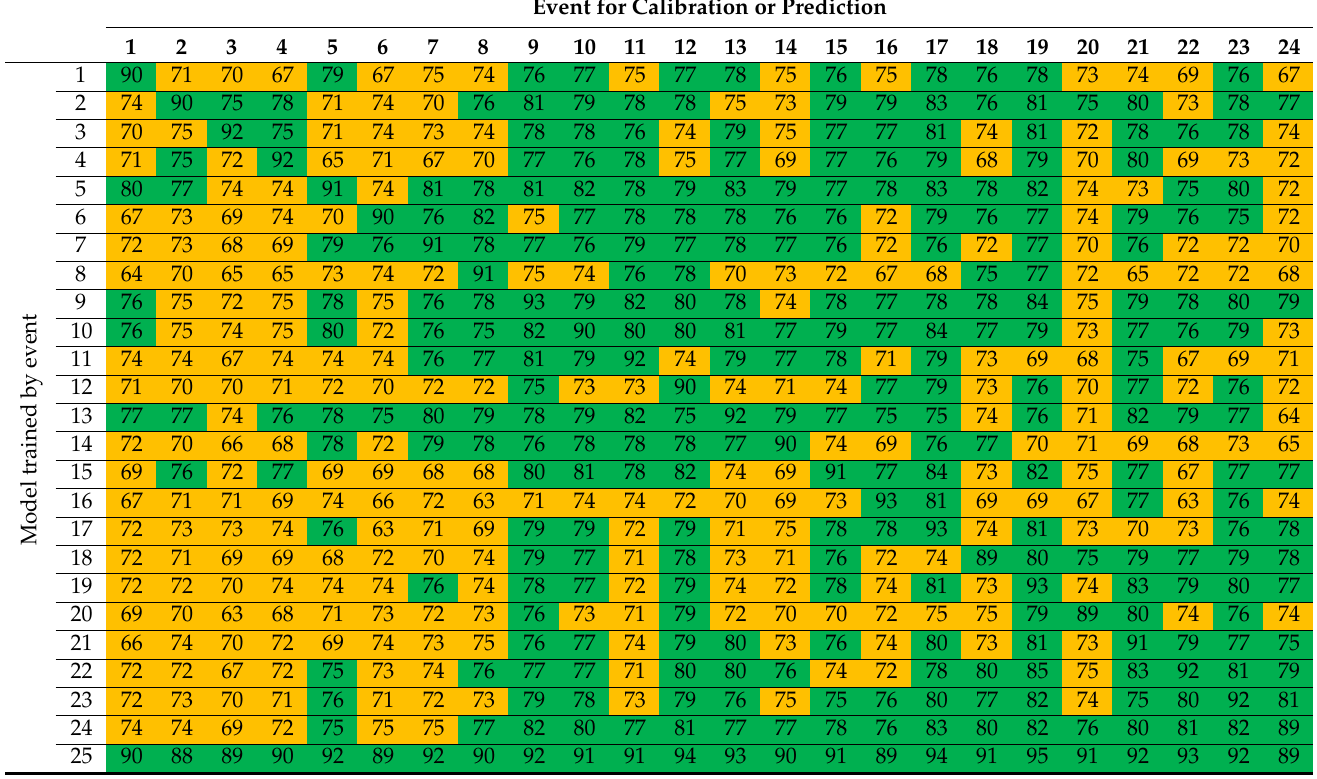
susceptibility models. In Figure 13, the average predictive accuracy of event-based PME models ( i = 1–24, j = 1–24, i (cid:54) = j , k = 7) ranged from 67.0% to 77.5% and the mean was